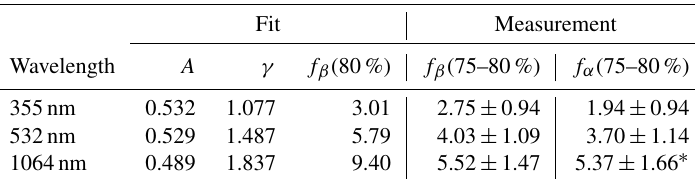
∗ Modeled lidar ratios used ( S wet = 35sr; S dry = 36sr; Table 1).